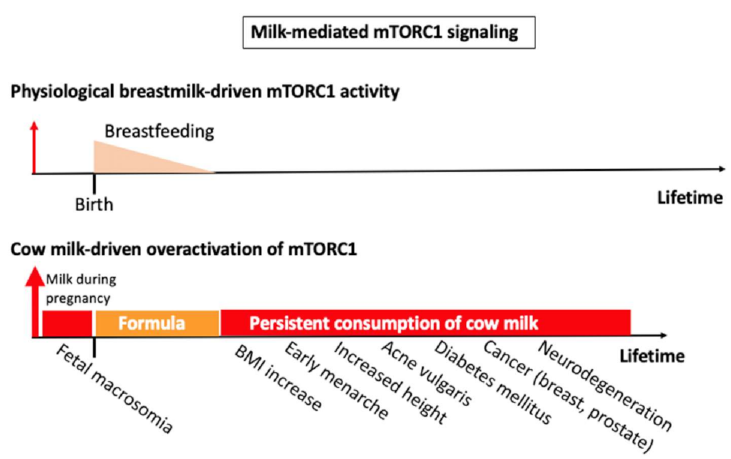
Figure 3. Milk-mediated mTORC1 signaling. Upper panel: physiological milk signaling exclusively only during the postnatal breastfeeding period with milk derived from the biological mother (human lactation genome). Lower panel: cow milk-driven overactivation of mTORC1 begins with maternal cow milk consumption during pregnancy, continues with high protein cow milk-based artificial formula, and continues with milk consumption during all age periods of human life. Persistent milk signaling with overactivated mTORC1 modifies growth trajectories during childhood and adolescence and promotes diseases of